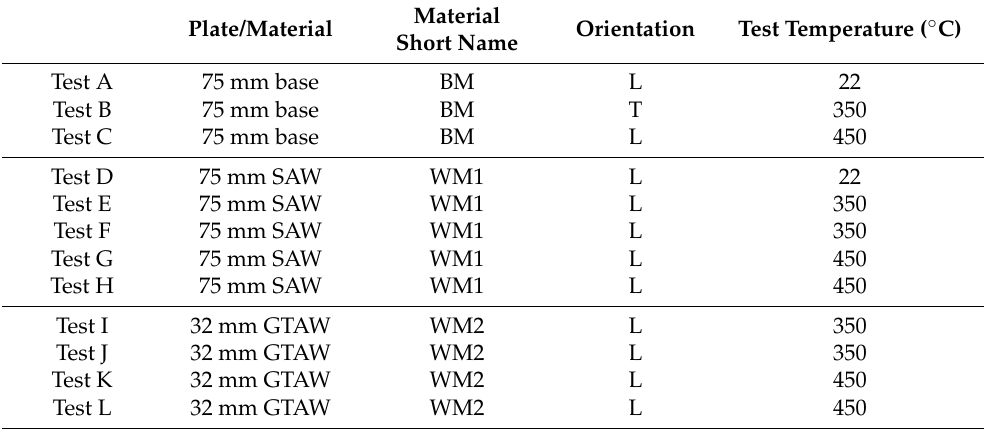
Table 2. Test matrix of SSRT tests presented in this